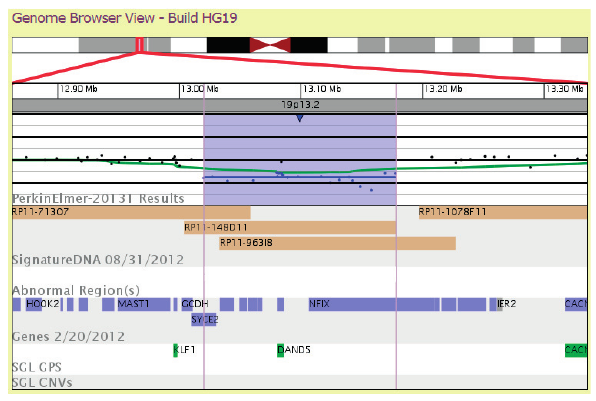
Fig. 2. PerkinElmer CGX™ HD v1.1 v1.1 4-plex array